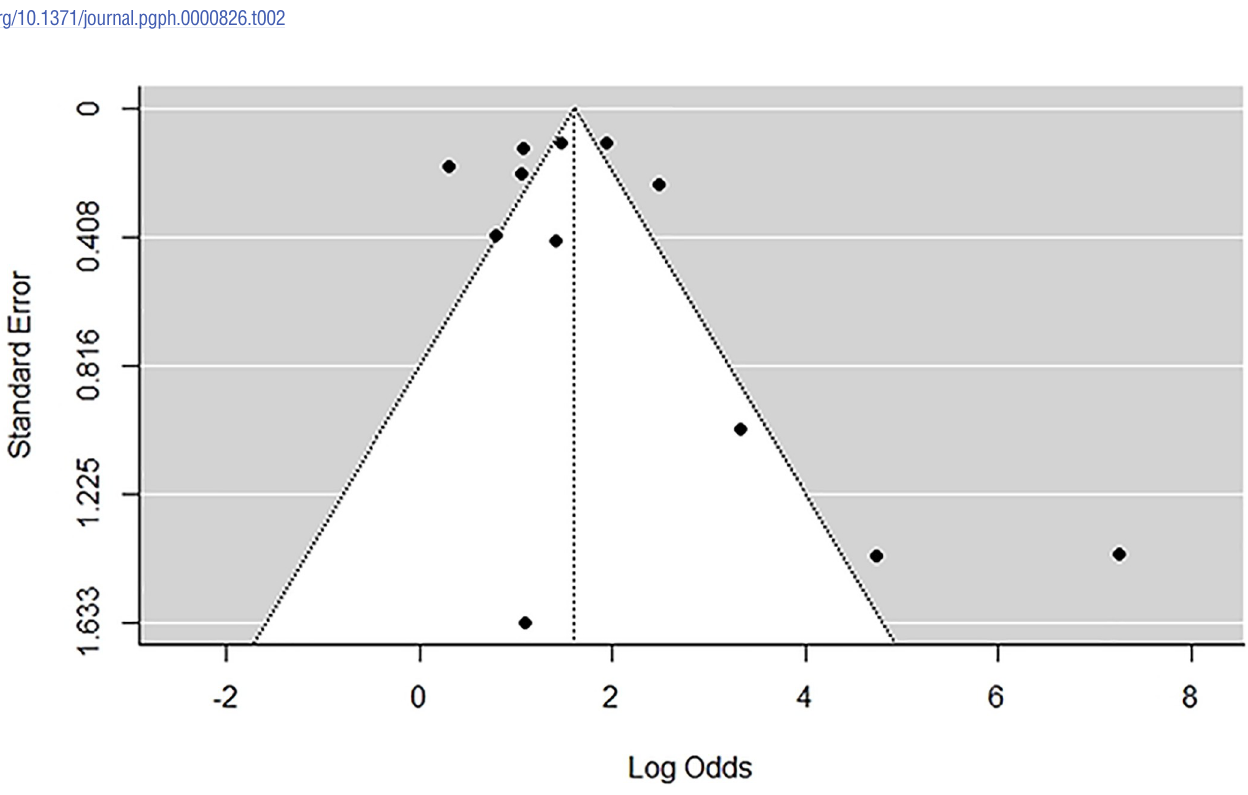
Fig 2. Funnel plot asymmetry of included studies reporting virological control as primary outcome. Though on a limited sample size, there was very few outliers.